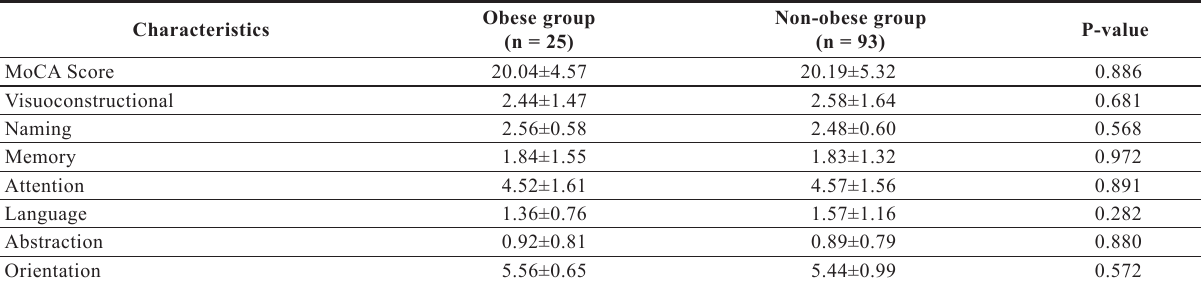
Table 2. Mean scores for cognition domains in obese and non-obese groups